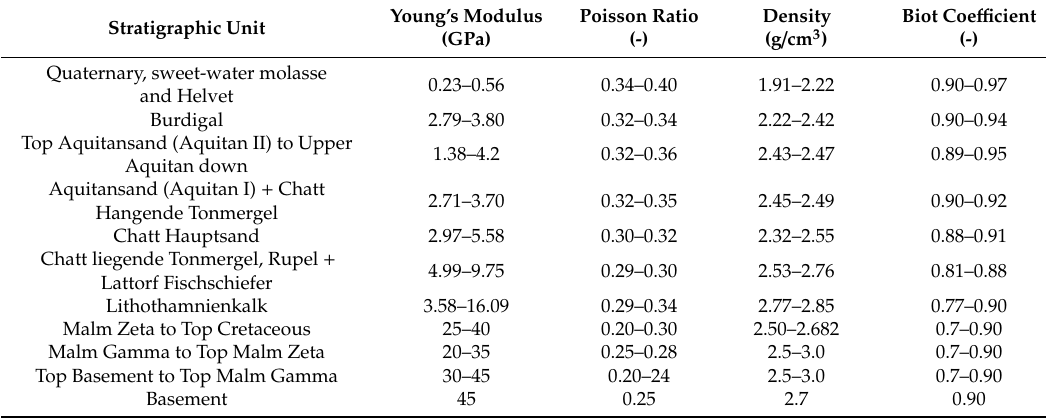
Table 1. Material properties of the reservoir along with overburden and underburden units of 3D geomechanical model.